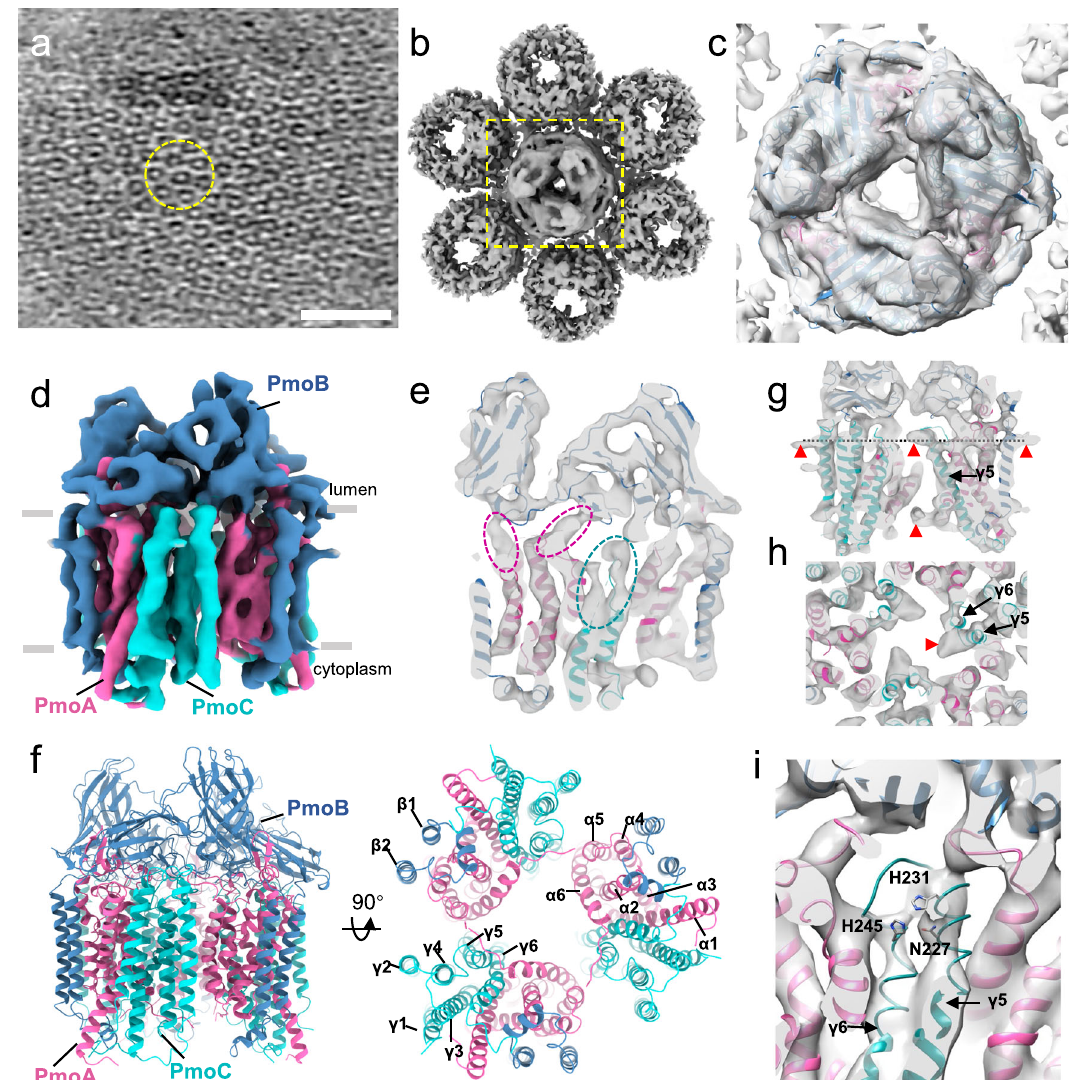
Fig.2|CryoETSTAofnativepMMOtrimerfromisolatedICMs.a Atomographic slice of isolated ICM (from n =187). A yellow dashed circle encloses a unit of 7 particles. b Subtomogram average of the 7-particle unit. c An enlarged view of the central particle in ( b ), superimposed with the docked crystal structure of the pMMO trimer (PDB 3RGB). d The pMMO trimer STA map at 4.8Å resolution, with each pMMO monomer consisting of PmoA (pink), PmoB (blue), and PmoC (cyan). e A central slice view of pMMO map superimposed with pMMO crystal structuremodel.ThedashedovalregionsindicatethedensitiesforPmoA(pink) and PmoC (cyan) that were not resolved in the previous crystal or cryoEM SPA